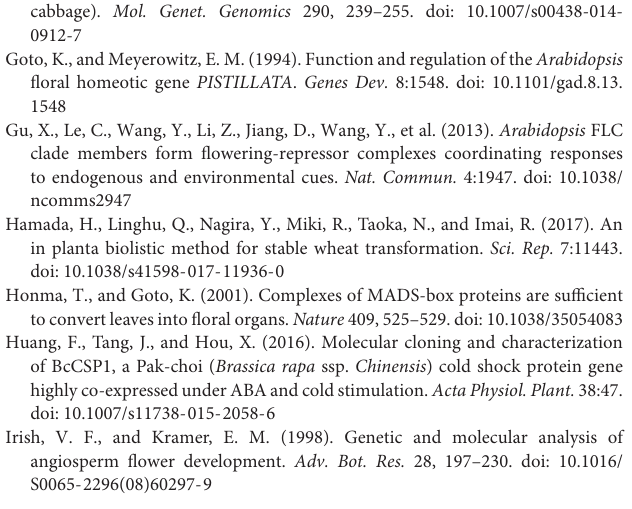
FIGURE S2 | Identification of T 3 transgenic Arabidopsis plants. (A) PCR analysis of T 3 transgenic Arabidopsis plants overexpressing empty vector (control) and